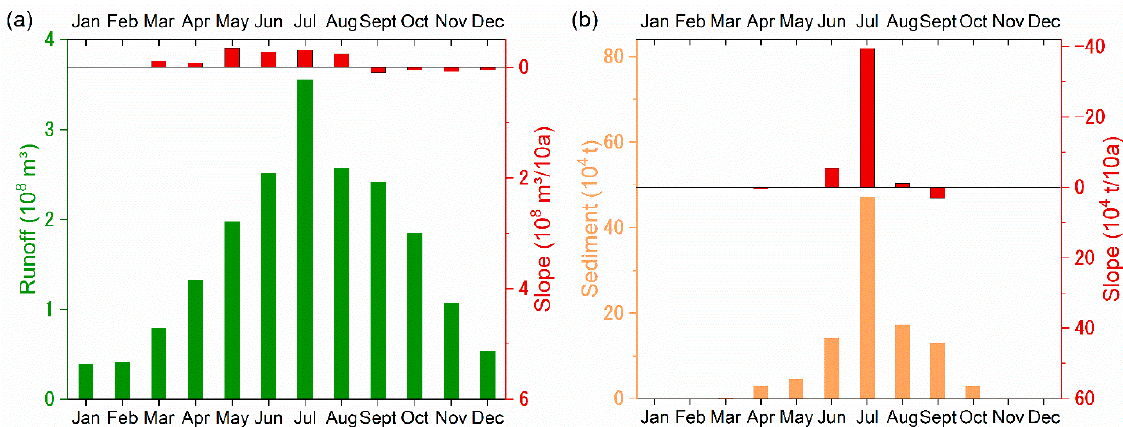
Figure 8. The average values and trends of monthly runoff and sediment in the Daning River basin: ( a ) runoff and ( b ) sediment.